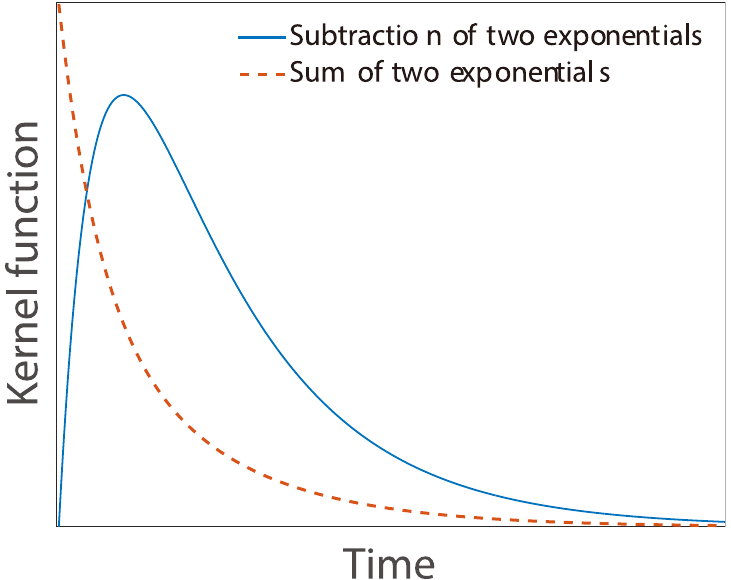
Fig 1. Illustration of the kernel with a subtraction of two exponentials (continuous blue line) and the kernel with a sum of two exponentials.